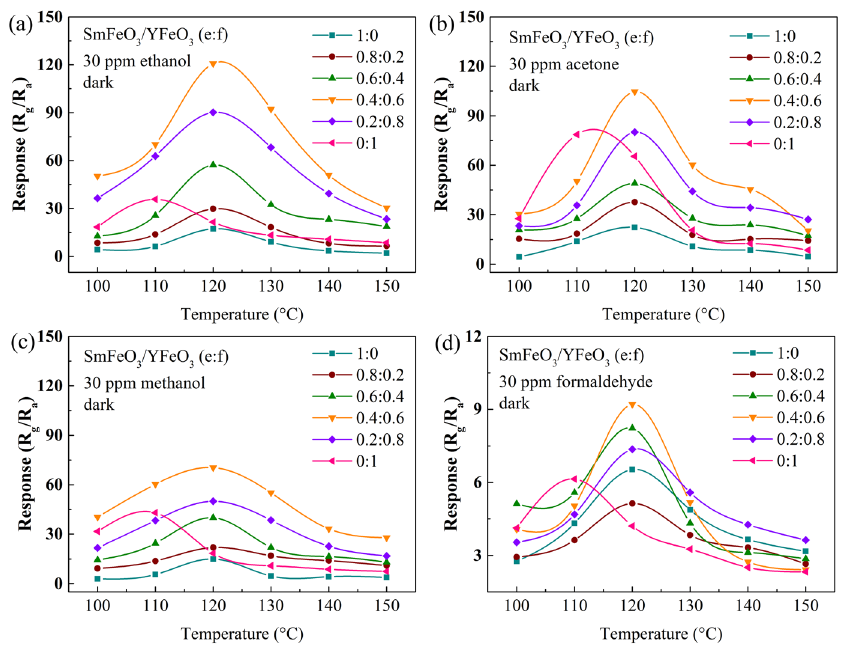
Figure 6. Response curves of the SmFeO 3 /YFeO 3 (e:f) sensor to VOC gases in the dark with temperature: ( a ) ethanol, ( b ) acetone, ( c ) methanol, and ( d ) formaldehyde.